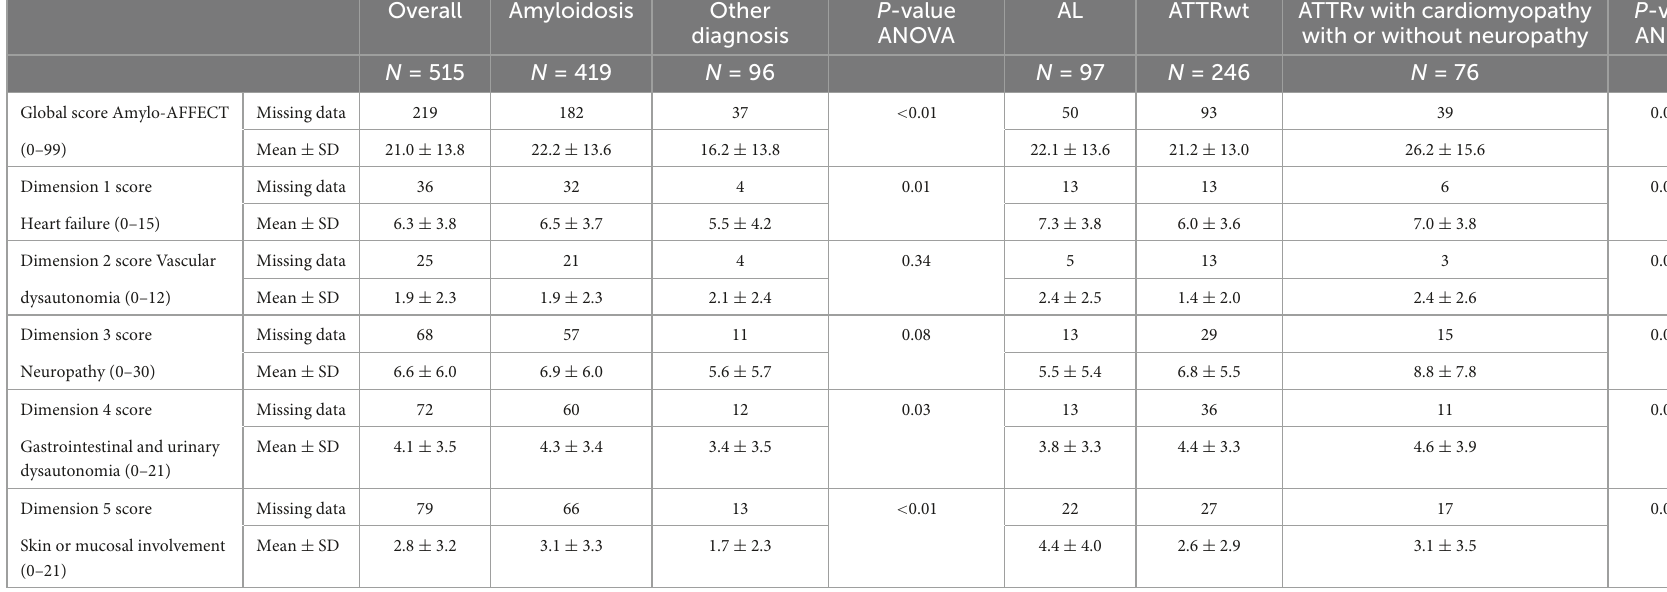
Overall Amyloidosis Other